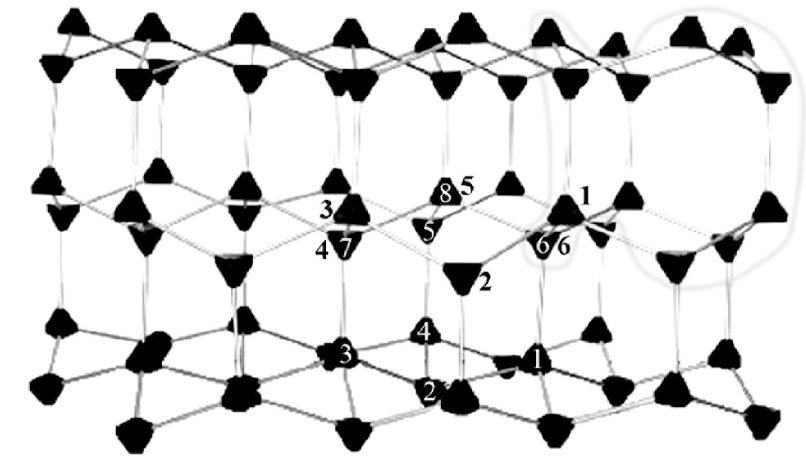
Figure 3. Relationship of C8 and C12 units in hexagonal diamond. White numbers inside carbon atoms indicate a C8 unit. Additions of carbon atoms to C8 generate cyclohexane rings (black numbers outside carbon atoms). The upper right C12 unit is